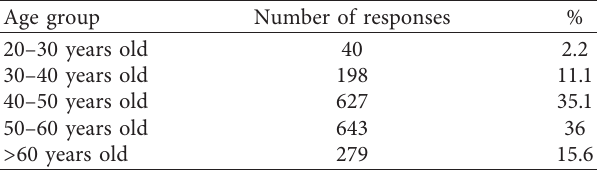
Table 1: IGSE administrators by age